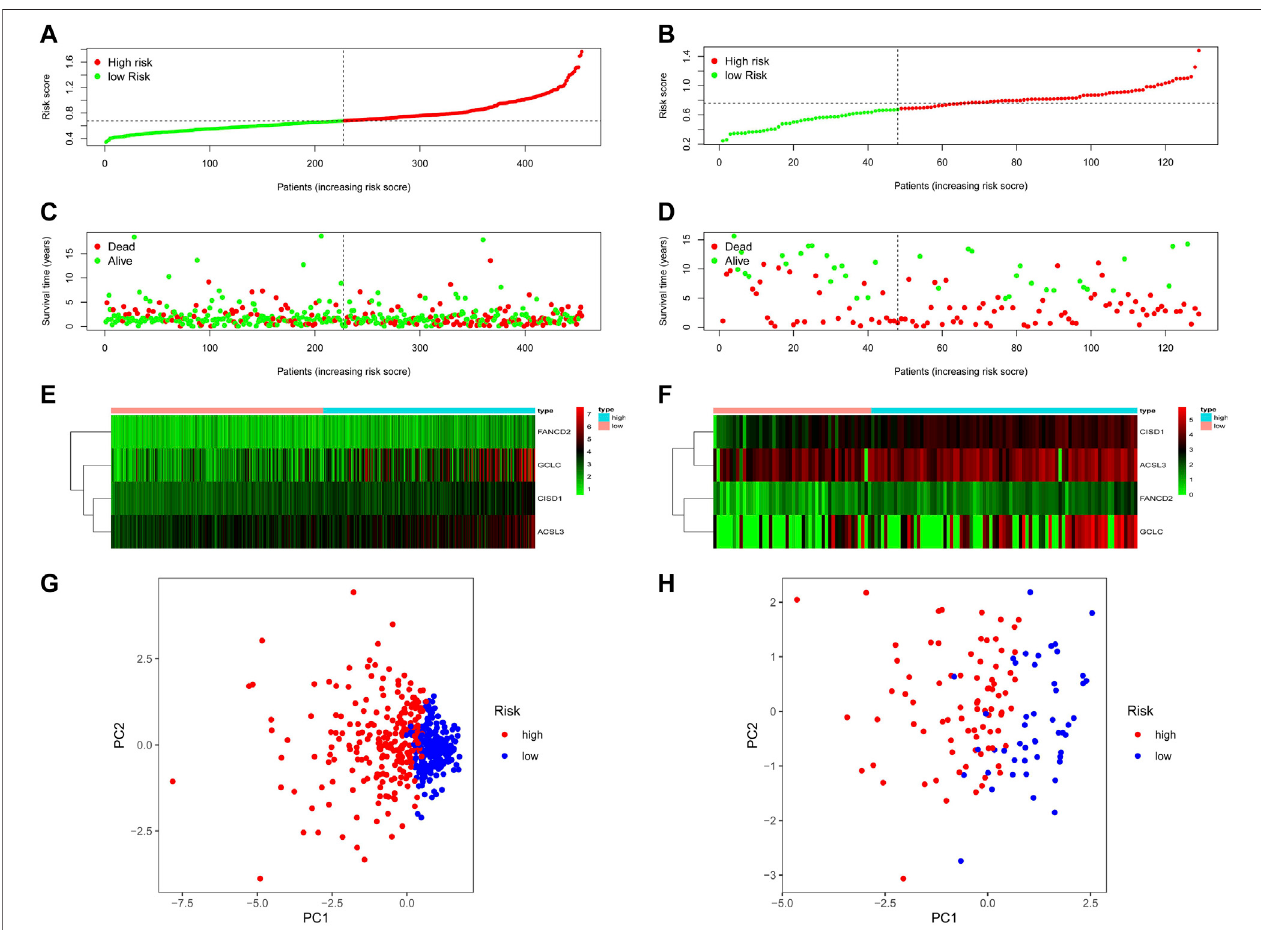
FIGURE4| The riskscore, survivalstatusdistribution, heatmapand PCA plotofTCGA and GEO cohort. (A) The distribution and median value oftheriskscoresin TCGA cohort. (B) The distribution and median value of the risk scores in the GEO cohort. (C) The distributions of OS status, OS, and risk score in TCGA cohort. (D) The distributions of OS status, OS, and risk score in the GEO cohort. (E) The heatmap for prognosis-associated ferroptosis-related genes in TCGA cohort. (F) The heatmap for prognosis-associated ferroptosis-related genes in the GEO cohort. (G) PCA plot of TCGA cohort. (H) PCA plot of the GEO cohort.